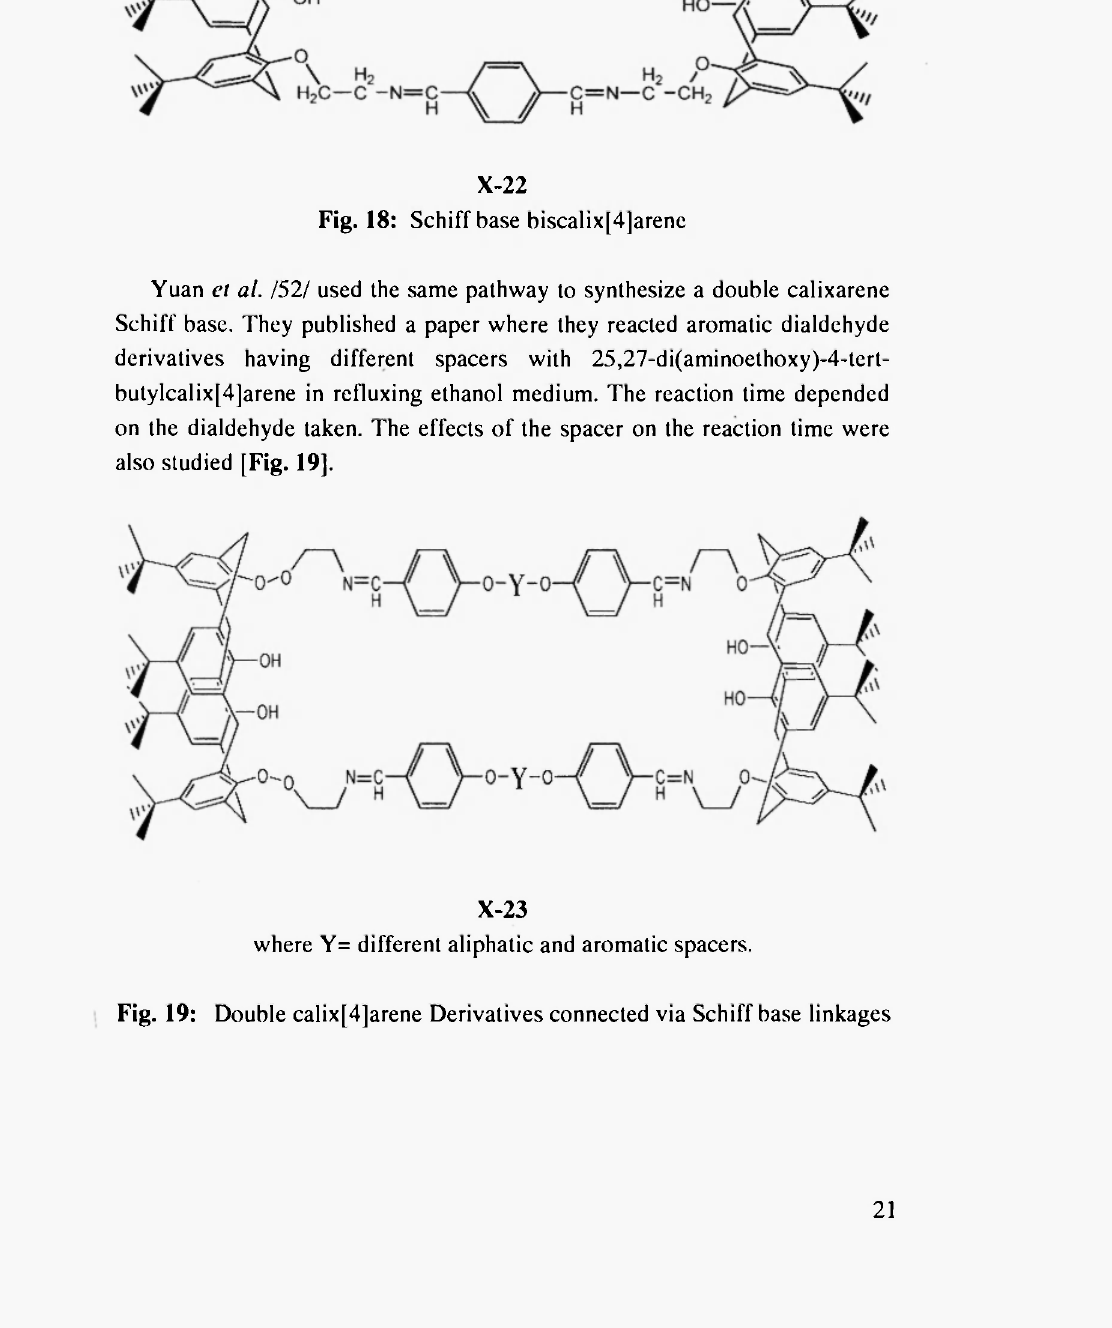
Fig. 18: Schiff base biscalix[4]arenc Yuan et al. 1521 used the same pathway to synthesize a double calixarene Schiff base. They published a paper where they reacted aromatic dialdehyde derivatives having different spacers with